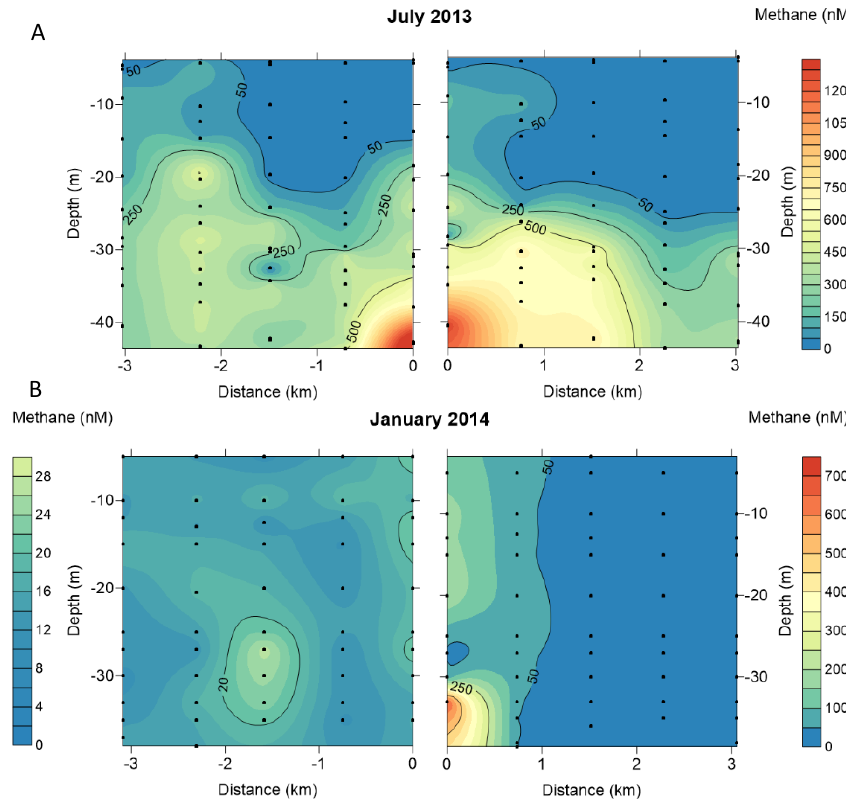
Figure 4. (a–b) Contour plots of the dissolved methane concentrations measured in the water column in July 2013 and January 2014. The 6km transect was divided into an eastern (positive numbers) and western part (negative numbers) starting from the center station at 0km. Note the different methane concentration scales, which are necessary to properly display the different concentration ranges. The black dots indicate the sampled water depths.